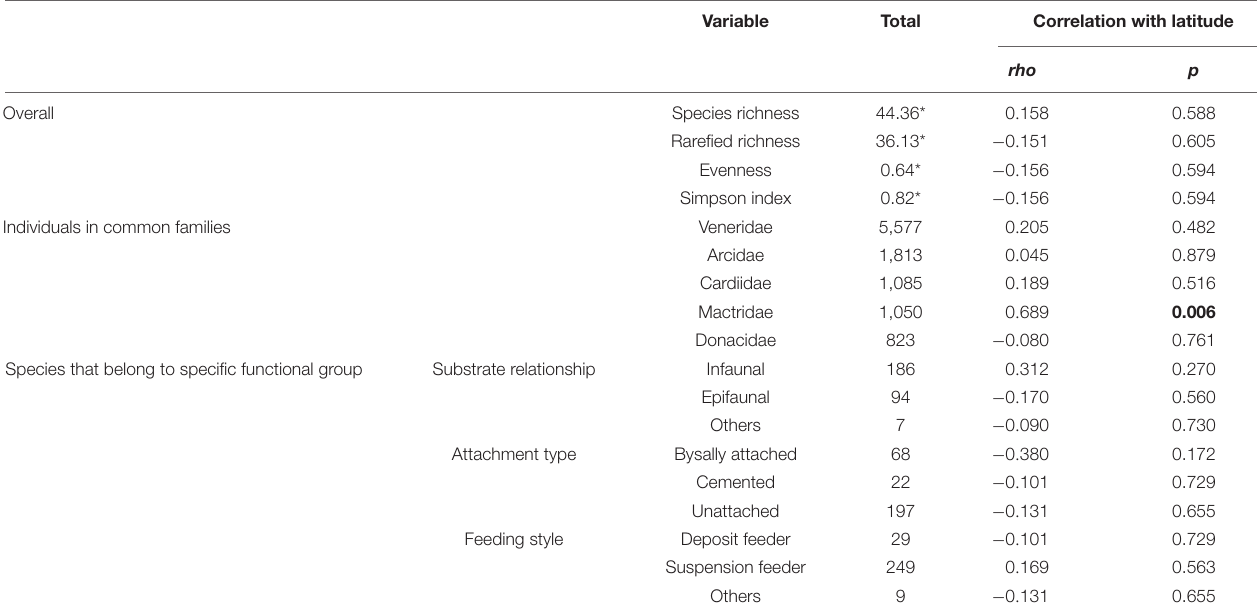
Variable Total Correlation with latitude rho